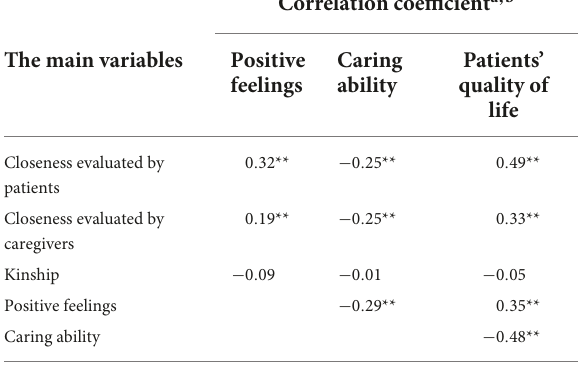
TABLE 2 Correlation between multiple main variables in pathways. +